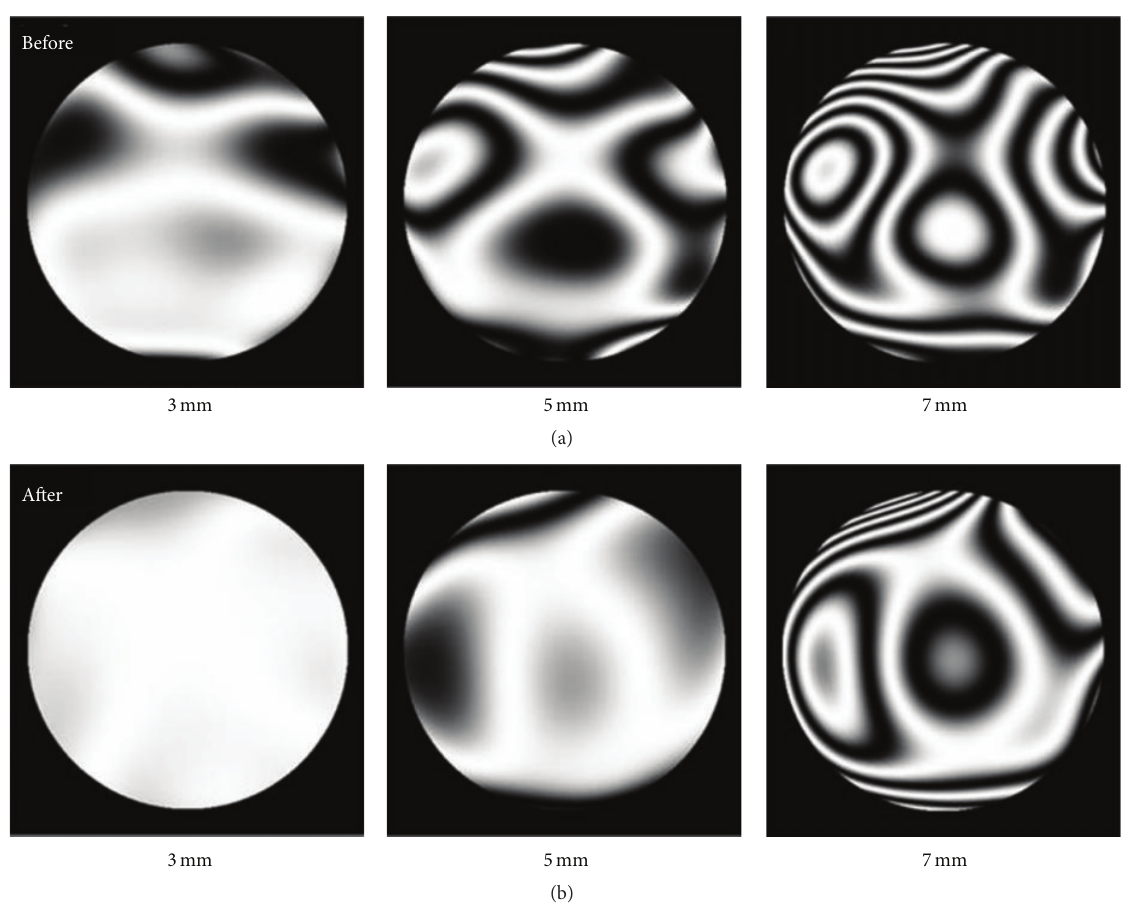
Figure 2: Corneal wavefront aberration contour plots of one patient receiving treatment. The patterns of (a) denote the results before treatment, while those of (b) denote the results after